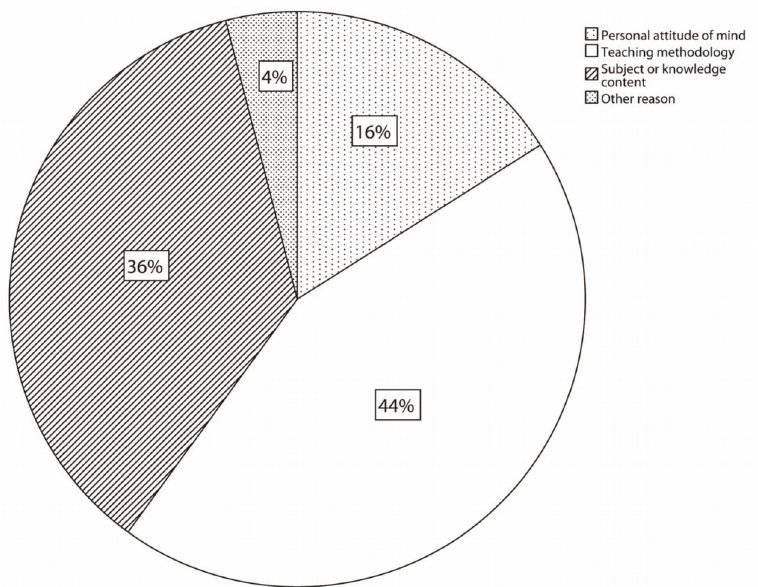
Figure 4. Reasons the students gave for choosing the prevalent emotion after each